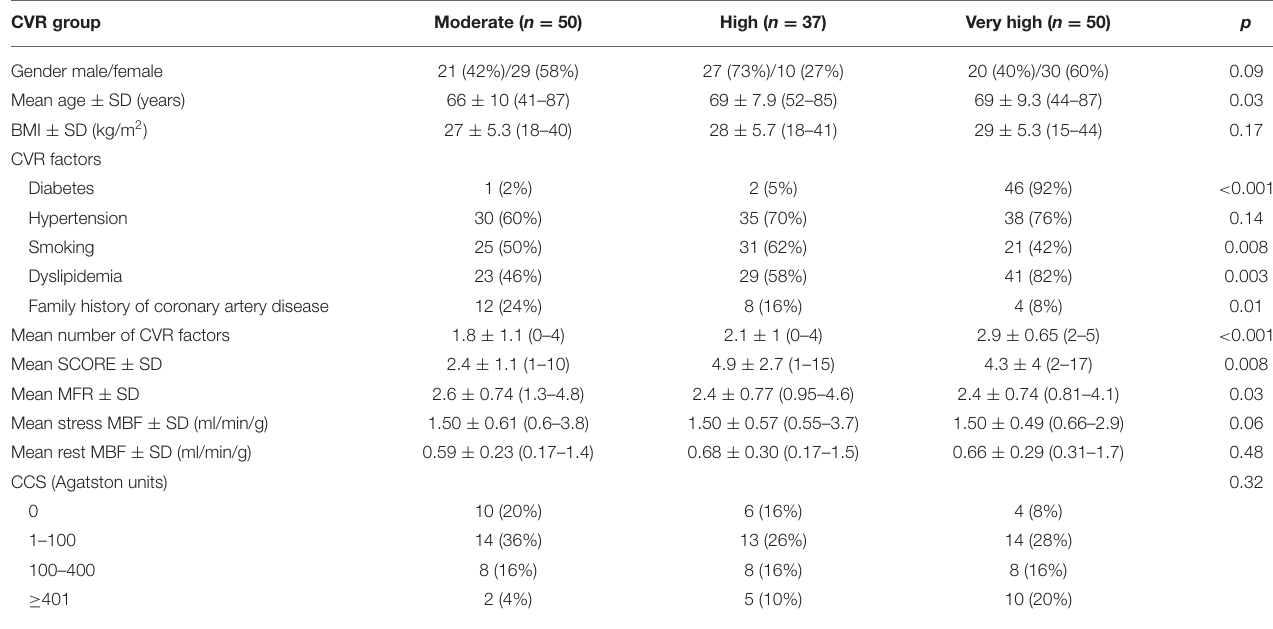
TABLE 2 | Clinical findings, myocardial flow reserve (MFR), and coronary calcium score (CCS) according to cardiovascular risk (CVR) groups. CVR